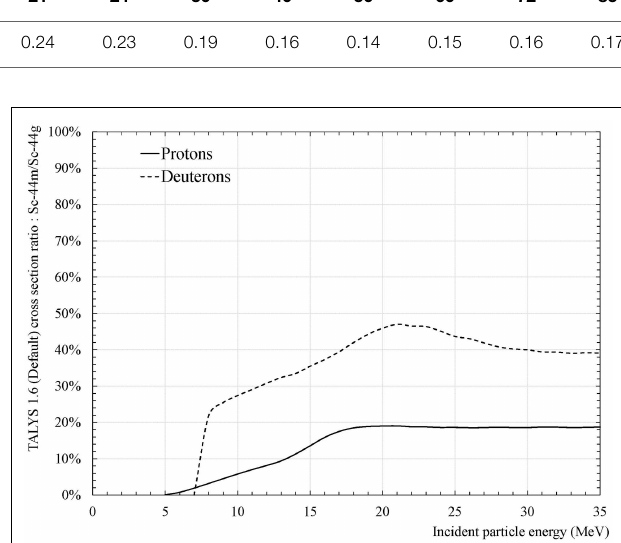
FIGURE 3 | Ratio of the cross section associated to Sc-44m over the cross-section associated to Sc-44g obtained from the TALYS code .